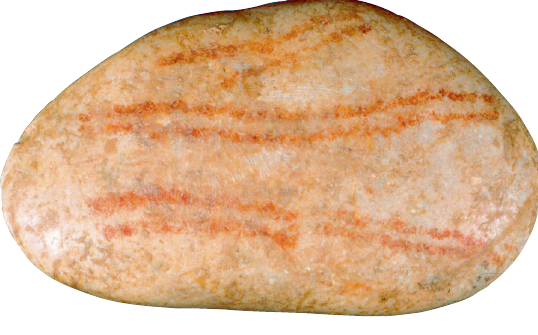
Figure 12. Obere Klause (Bavaria), painted limestone, found 1912. Photo: Prähistorische Staatssammlung, München, modified.